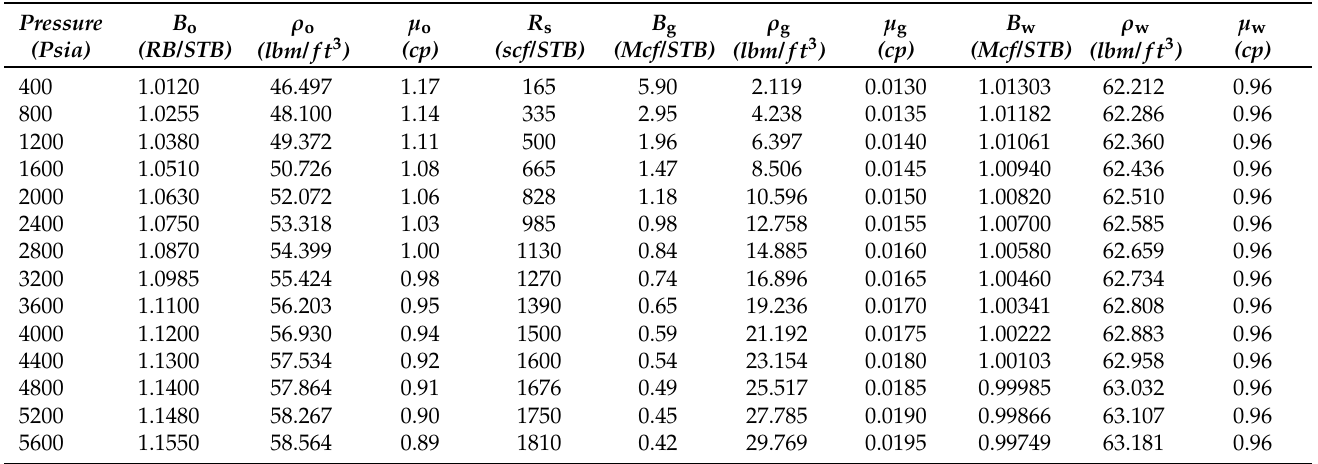
Table 3. PVT Table for SCSP